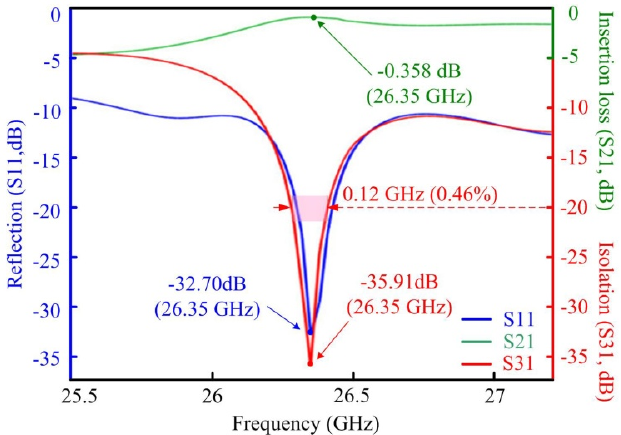
Figure 6. External characteristics of the microwave photonic circulator. The blue S11 reflection dip coincides with the red isolation S31 dip, showing a suitable working bandwidth (indicated by the pink band) for the designed circulator. In this band, incident signals into port 1 would be optimally directed to port 2 without being either reflected back into port 1 or directed towards port 3.